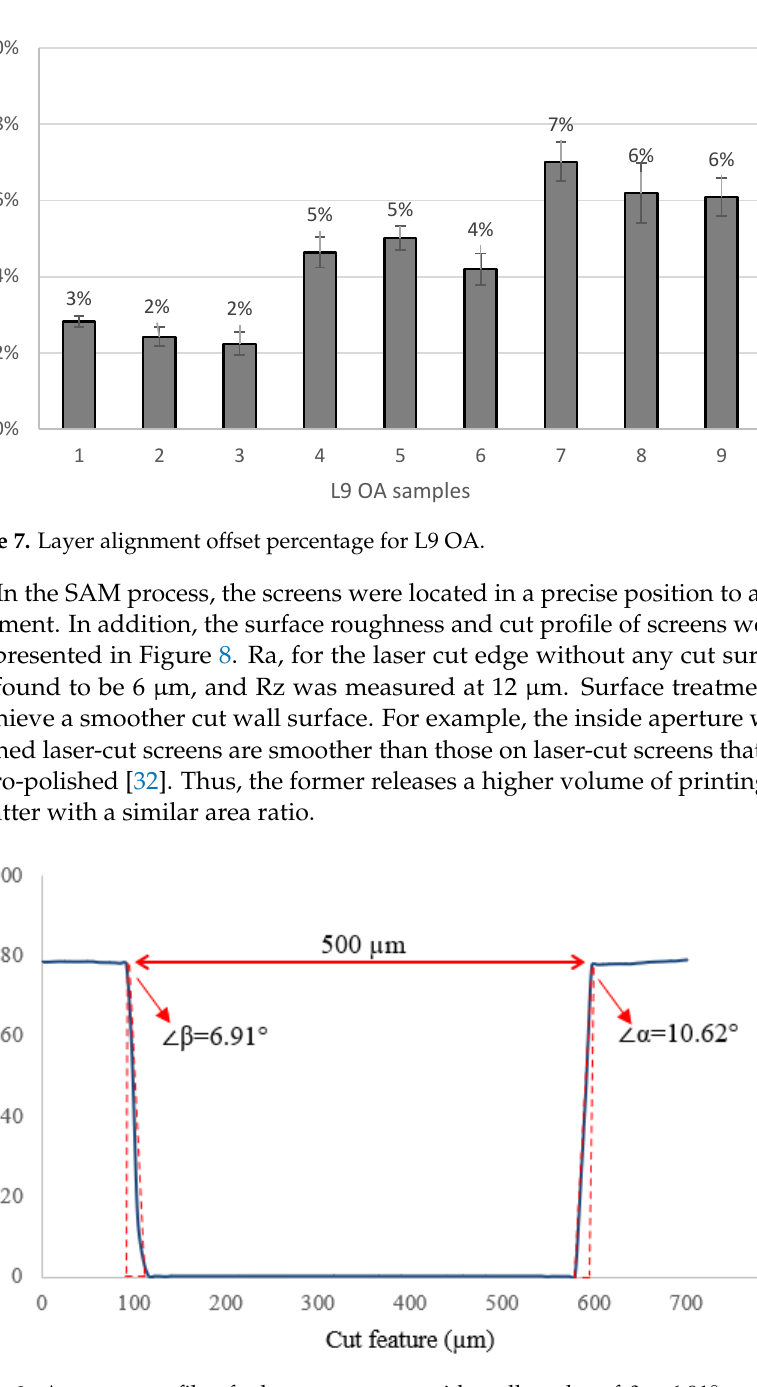
Figure 8. Aperture profile of a laser-cut screen with wall angles of β = 6.91 ◦ and α = 10.62 ◦ , the aperture width 500μm and stencil thickness of 80 μm.